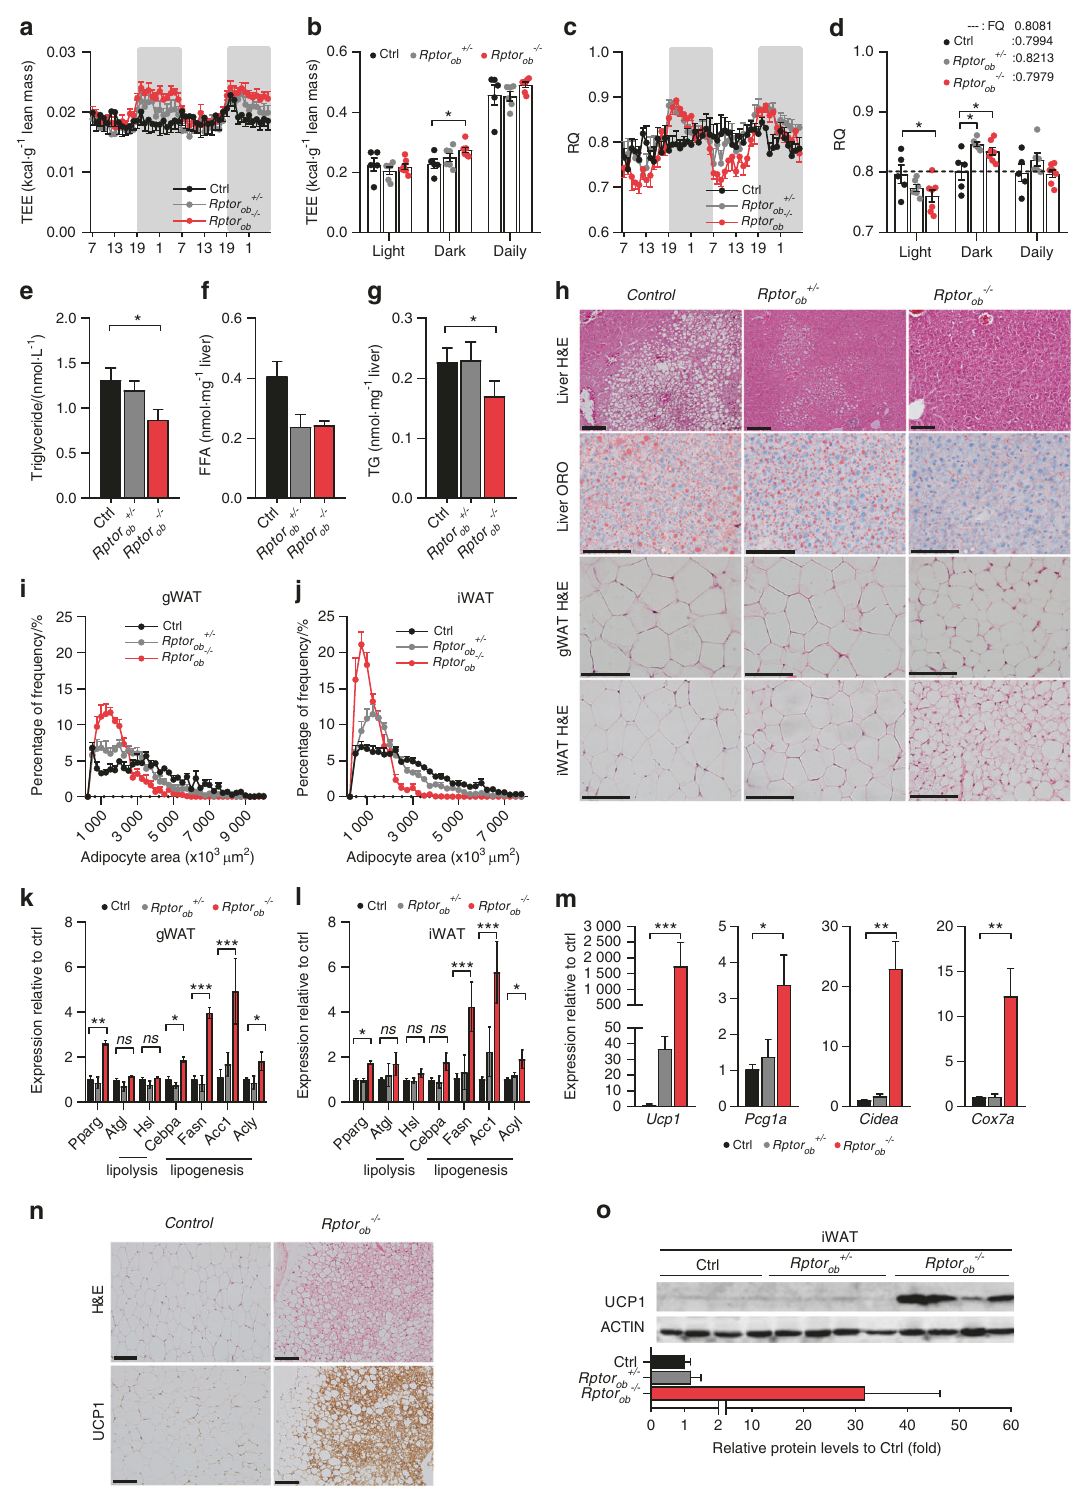
Fig. 6 HFD-fed Rptor ob − / − mice exhibit greater substrate fl exibility and browning of white adipose tissue. a Total energy expenditure (TEE), normalized to lean mass, over 48 h and b per light/dark cycle. c Average RQ over 48 h and d per light/dark cycle. e Serum triglyceride levels ( n = 8 – 10/genotype). f Hepatic triglyceride levels and g hepatic free fatty acid levels in 18-week-old HFD-fed mice ( n = 3 – 4/genotype). h Representative images of H&E and Oil Red O-stained sections of liver, gWAT, and iWAT, scale bar = 100 µm. i , j Size distribution of gWAT and iWAT adipocytes calculated from H&E stained sections using Image J ( n = 5 sections/mouse, n = 5 – 6/genotype). k , l Gene expression levels of adipogenesis, de novo lipogenesis, and lipolysis markers in gWAT and iWAT tissues, normalized to Actb ( n = 3 – 5/genotype). m Gene expression levels of brown adipose tissue markers in iWAT tissue, normalized to Actb ( n = 3 – 5/genotype). n Representative images of H&E and UCP1 immunostaining section of iWAT from HFD-fed mice, scale bar = 100µm. o Levels of UCP1 protein expression in iWAT ( top ) and quantitative analysis of protein levels relative to β -actin ( bottom ) ( n = 4/genotype). Data are expressed as mean ±SEM. * P < 0.05, ** P <0.01, *** P <0.001, one-way ANOVA with Tukey ’ s post hoc